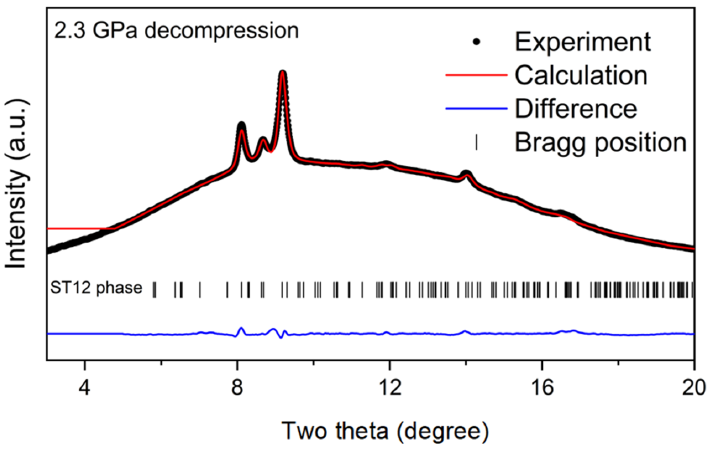
Figure 3. The representative refinement pattern under 2.3 GPa during decompression. The structure is well-fitted to ST12 phase of Ge.